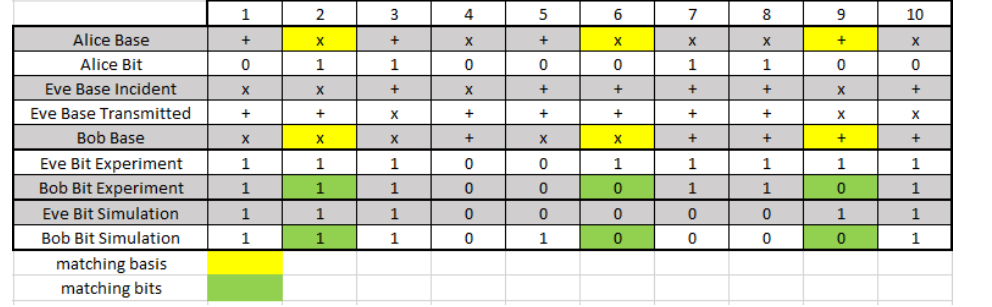
Figure A3. 10 bit transmission results from Alice to Bob with Eve—experiment and simulation.